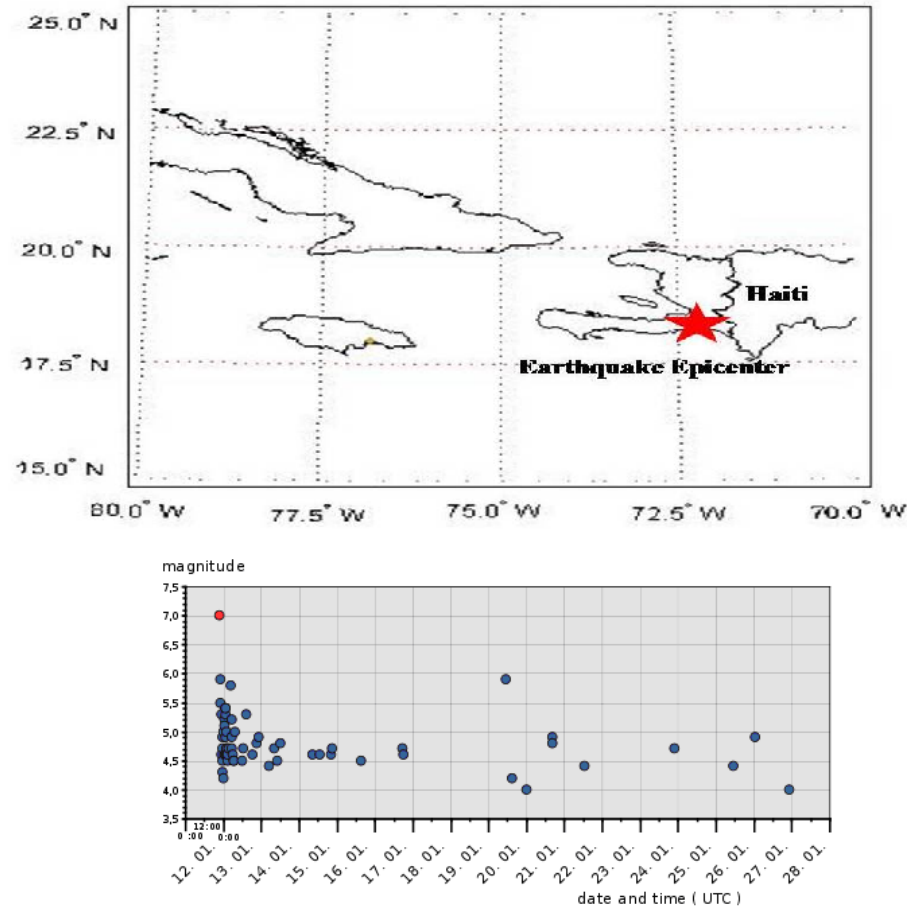
Fig. 1. Map showing the epicenter of the Haiti earthquake (downloaded from www.earth.google.com) in the upper panel. Magnitude and occurrence of the main aftershocks are shown in the lower